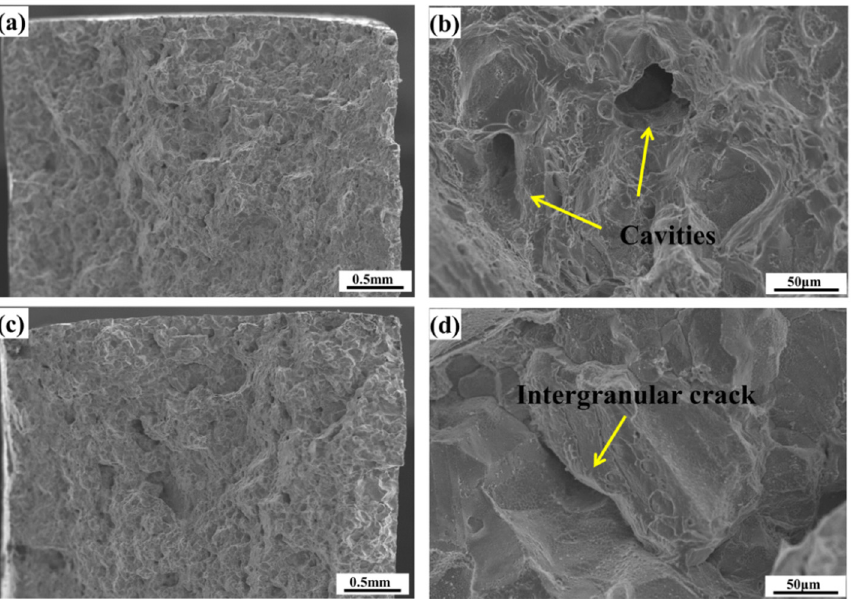
Figure 5. Fracture morphology of the creep rupture specimens: ( a ) macroscopic morphology under 238 MPa, ( b ) the amplified fracture surfaces of ( a ), ( c ) the macroscopic morphology under 170 MPa, ( d ) the amplified fracture surfaces of ( c ).